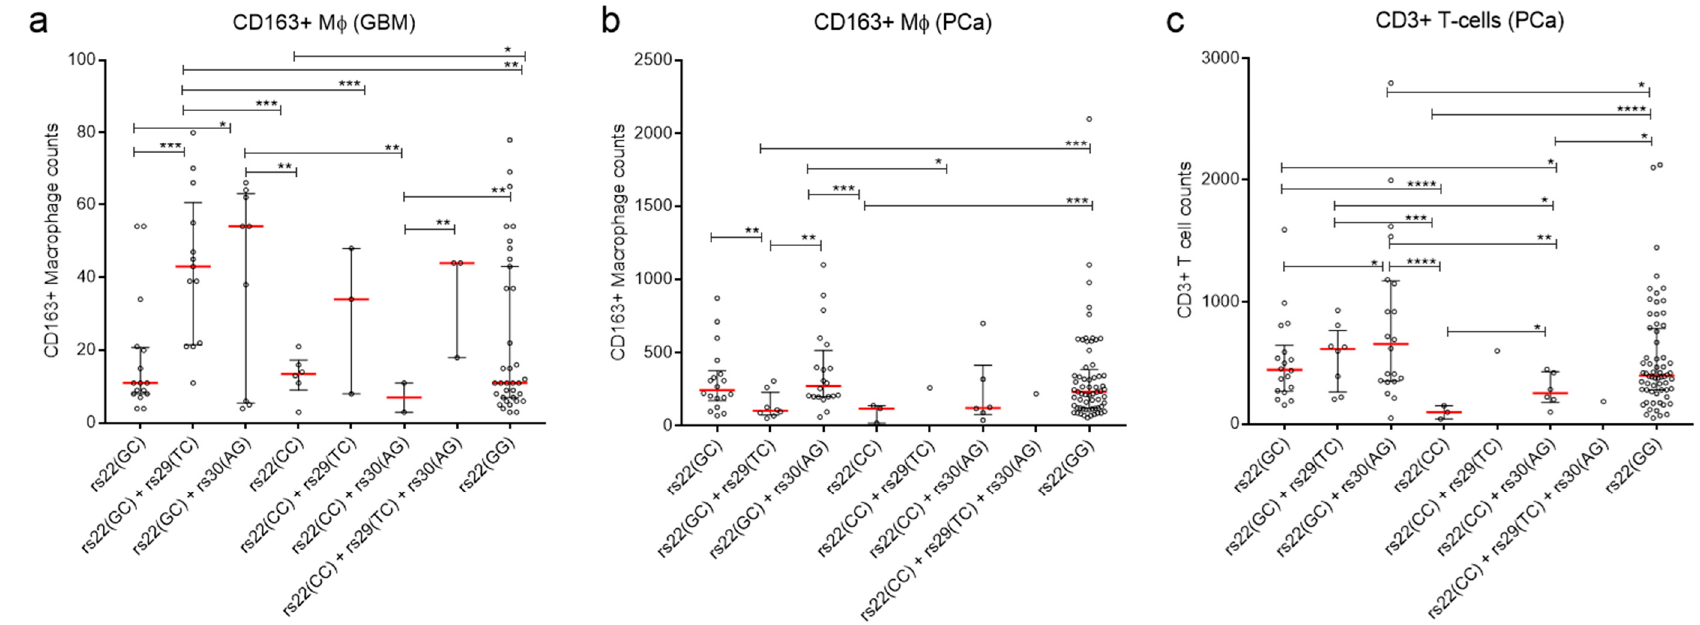
Figure 3. Intronic SNPs (rs29 and rs30) influences the amount of CD163 + M φ in GBM and PCa patients and CD3 + T cells in PCa patients. ( a ) CD163 + M φ count in GBMs. ( b ) CD163 + M φ count in PCa. ( c ) CD3 + T cell count in PCa. ( a – c ) Dot plot of CD163 + M φ or CD3 + T cells. Each dot represents the respective immune cell count from individual tumours. Red line—median with whiskers—interquartile range. Significance was determined using the Welch’s t-test. *— p value. * < 0.05, ** < 0.01, *** < 0.001 and **** < 0.0001, respectively.